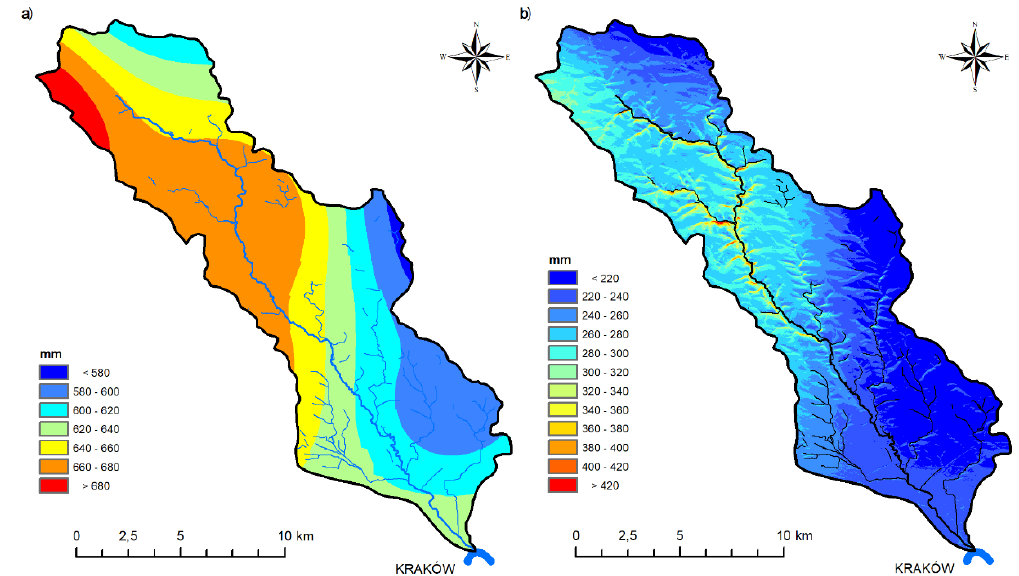
Figure 6. ( a ) Mean annual precipitation and ( b ) annual climatic water balance in the Prądnik river basin.